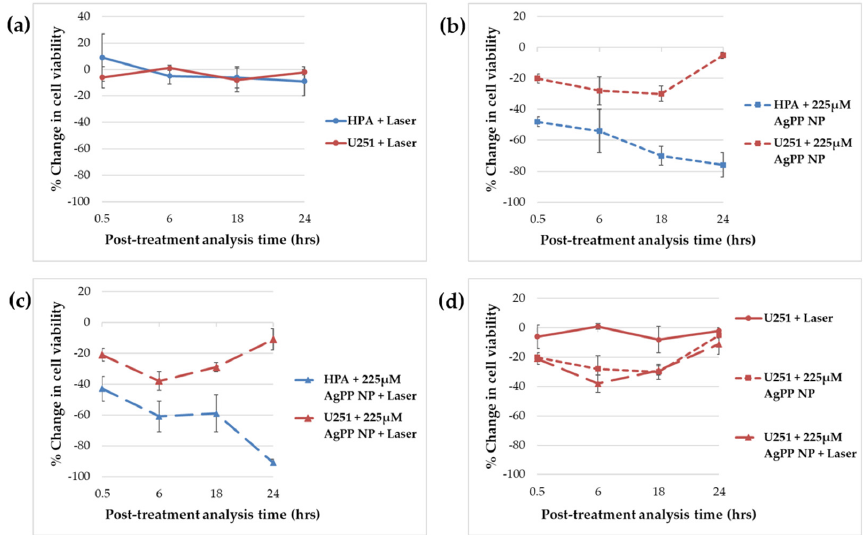
Figure 7. Comparison of percentage change in cell viability of HPA and U251 cells upon treatment with ( a ) laser alone, ( b ) 225 μ M AgPP NP alone, ( c ) 225 μ M AgPP NP in com- bination with laser. ( d ) cumulative GBM chart comparing treatments ( a ), ( b ) and ( c ) for U251